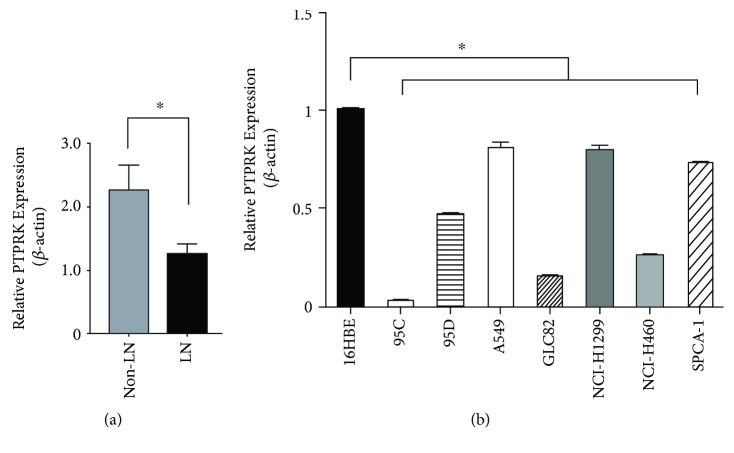
PTPRK is frequently underexpressed in NSCLC with lymph node (LN) metastasis. (a) PTPRK mRNA expression was quantified by qRT-PCR in 30 lung tumors with non-lymph node metastasis and 16 tumors with lymph node metastasis. (b) qRT-PCR analysis of PTPRK expression levels in one normal human bronchial epithelial cell (16HBE) and seven NSCLC cell lines, and expression levels were all normalized to 16HBE.